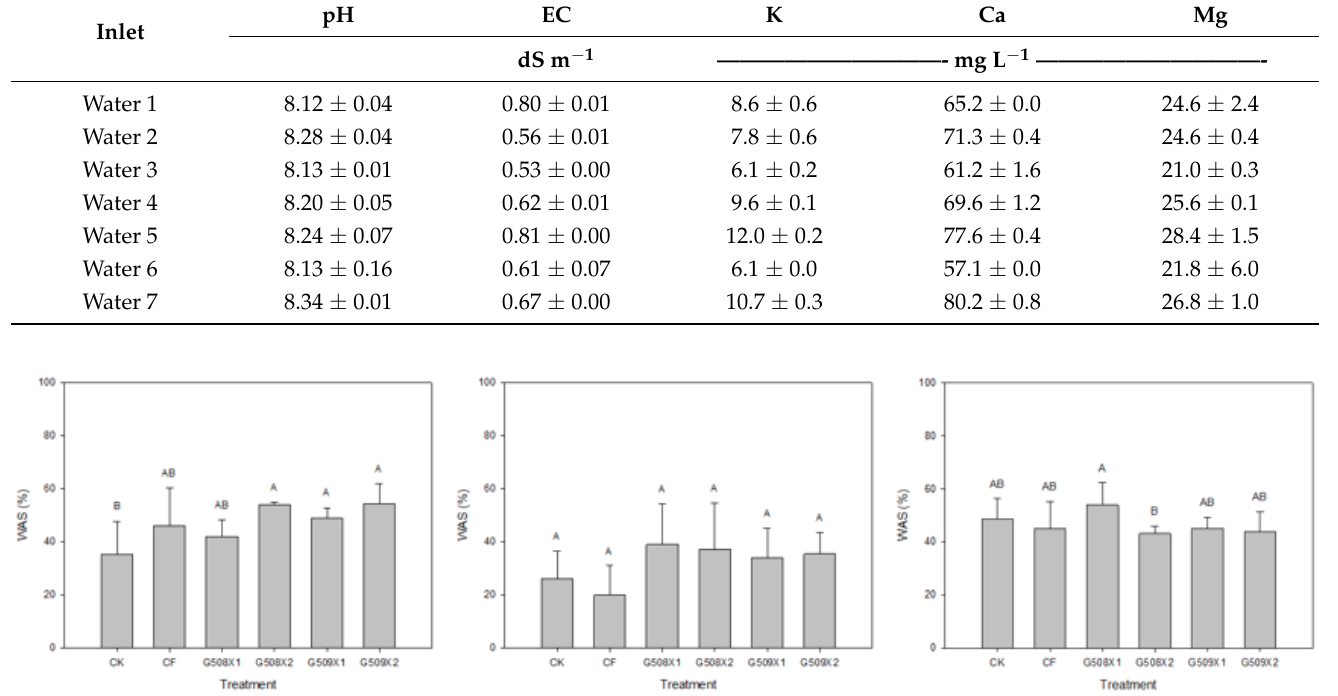
Table A2. Basic properties of irrigation water at different locations.